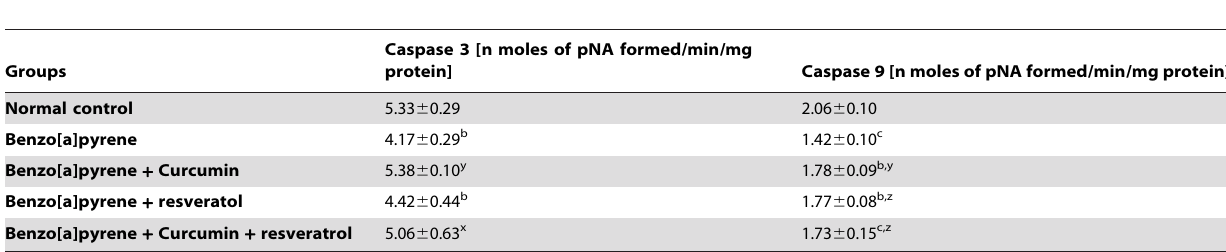
Table 2. Effects of curcumin and resveratrol treatments for 22 weeks on the enzyme activities of caspase 3 and caspase 9 in lungs during benzo[a]pyrene induced lung